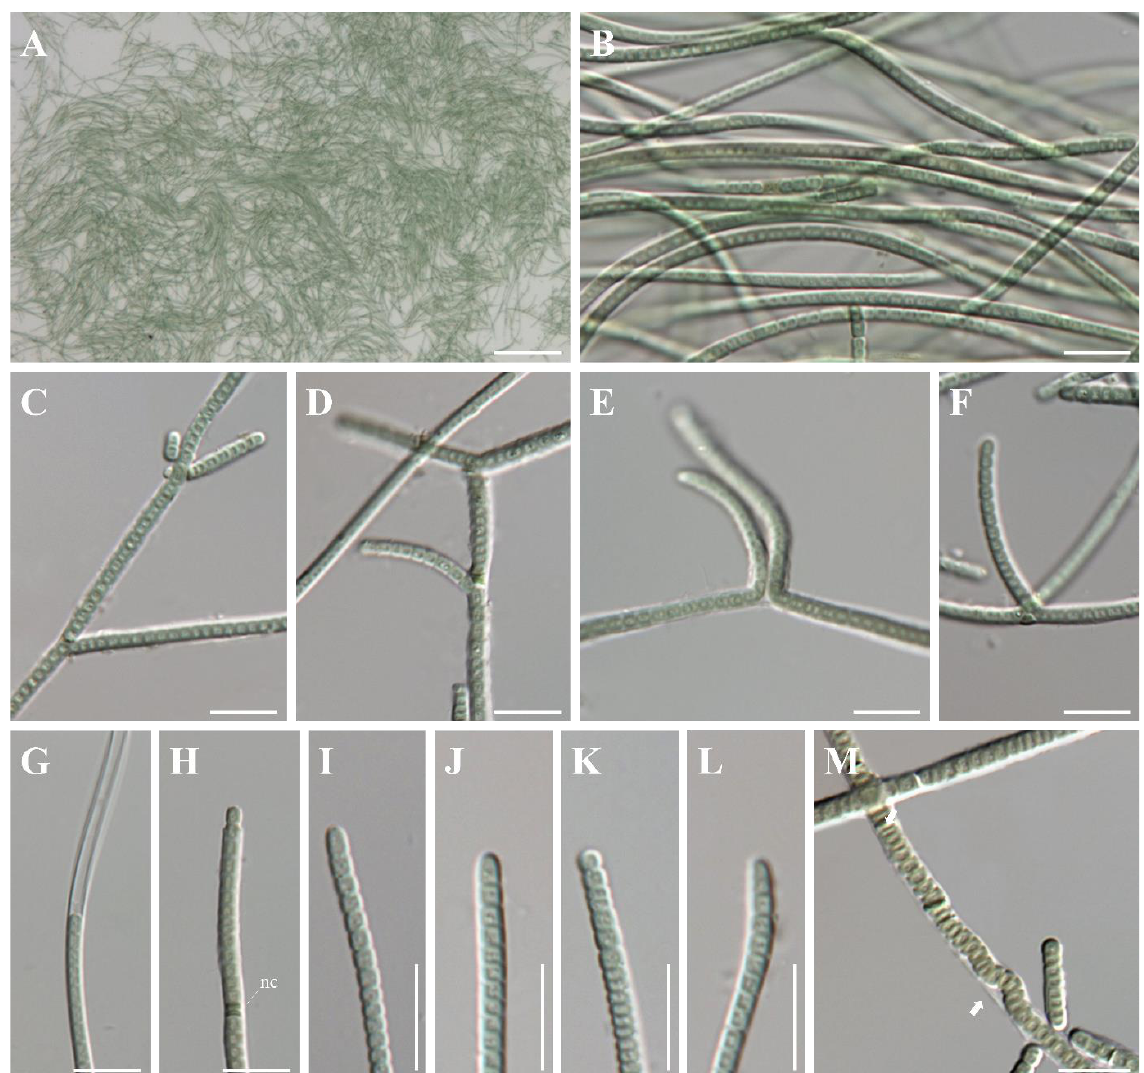
Figure 4. Microphotographs of Plectolyngbya koreana from the strain FBCC-A1478. ( A ) Colonies (mats) formed in culture. ( B ) Detail of trichomes. ( C , D ) Tolypothrix -type of false branching. ( E , F ) Scytonema -type of false branching. ( G ) Trichome with sheath. ( H ) Trichome with the necridic cell (nc) coming out of the sheath. ( I – L ) Morphologies of apical cells. ( M ) Trichome with sheaths (arrow) after 4 weeks of culture. Scale bars ( A ) 100 μm, ( B – M ) 10 μm. Notes: Plectolyngbya koreana has slightly longer cells than the other species of Plectolyn- gbya . The D1–D1 (cid:48) helix shows a similar loop to other species; however, the Box-B helix is distinguished by its shorter length than the other Plectolyngbya species. TEM analyses have also found multilayered sheaths of trichomes (Figure